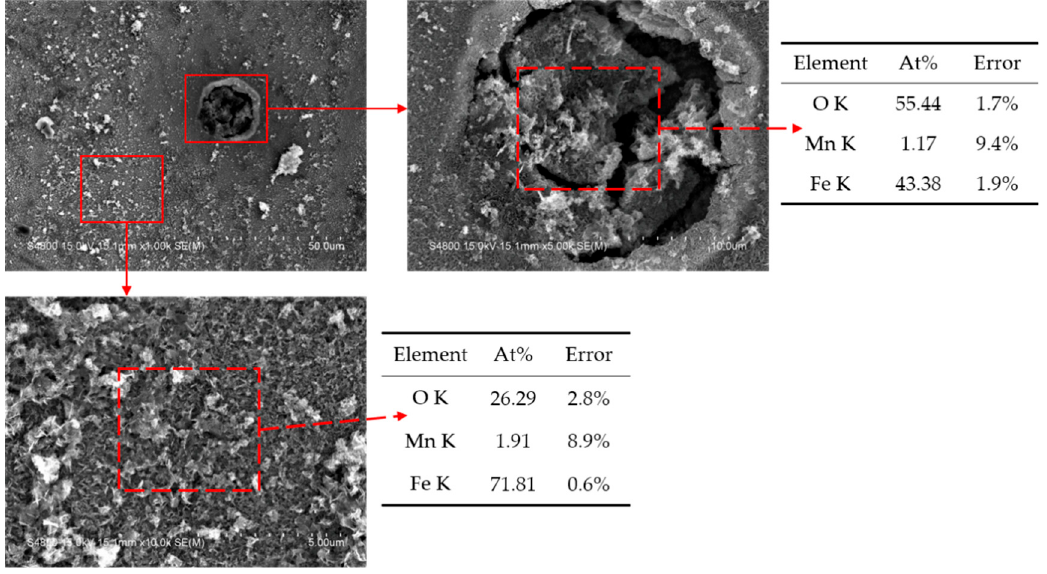
Figure 5. Scanning electron microscope (SEM) images and the corresponding composition analysis of the passive film formed on A508-3 with the blank treatment.